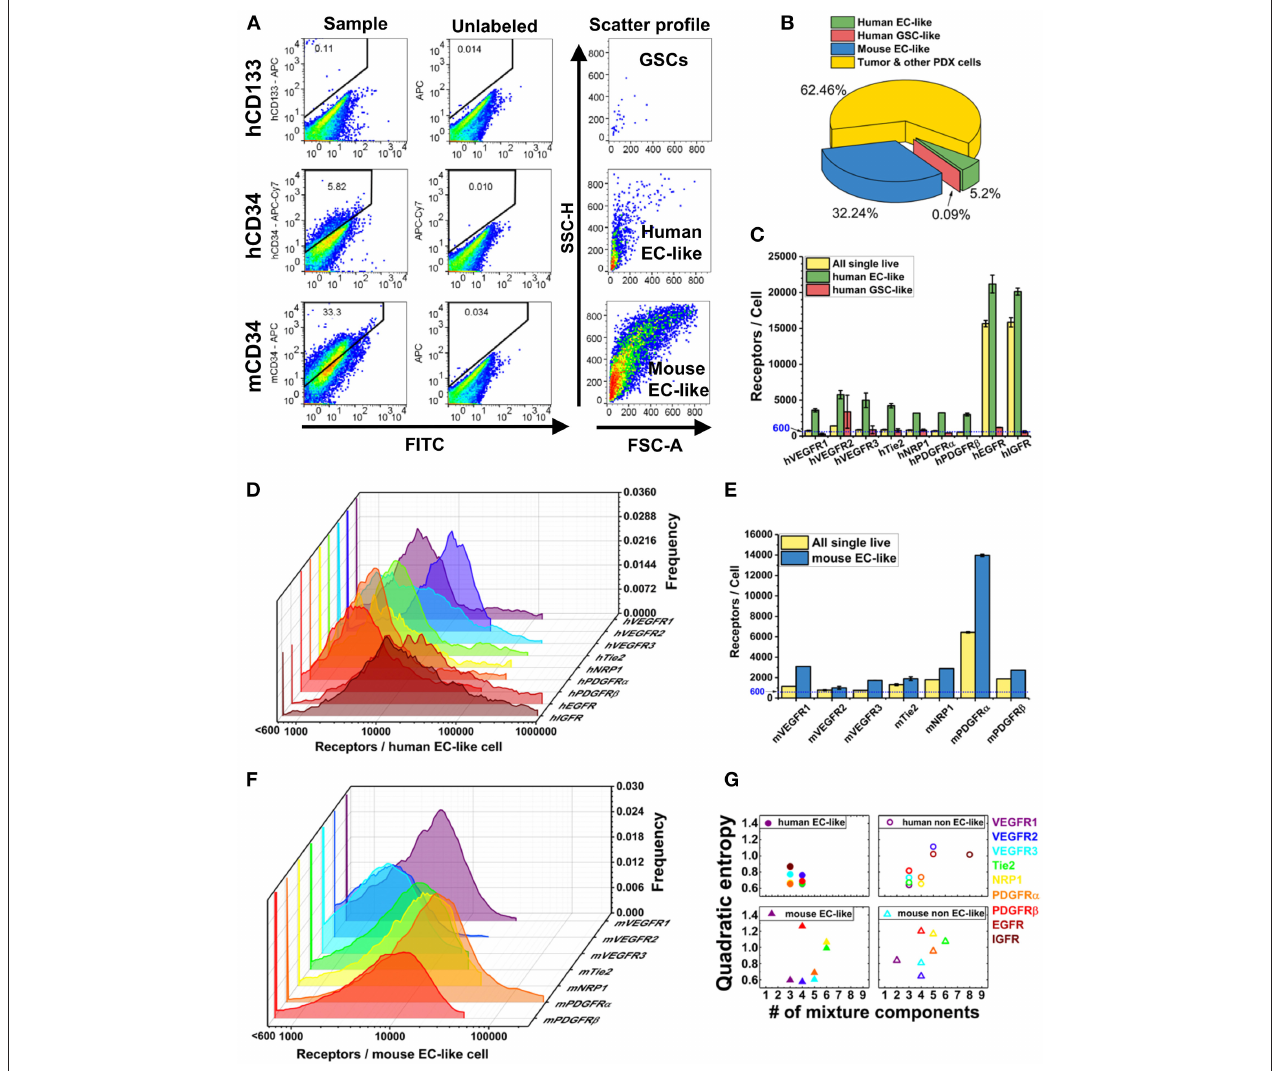
FIGURE 2 | Characterization of plasma membrane RTK concentrations and tumor heterogeneity in GBM39 PDX sample using a LSR Fortessa flow cytometer (BD). We obtain fluorescence signal from 2 to 3 sample tubes for each RTK with 10,000–35,000 live single cells per sample tube. BD FACSDIVA software was used for data acquisition, and FlowJo (TreeStar) software was used for data analysis. (A) Representative flow cytometry plots for gating GSCs (hCD45-hCD133 + ), human EC-like cells (hCD45-hCD34 + ), and mouse EC-like cells (mCD45-mCD34 + ) from live cell population. (B) Percentage of GSCs, human EC-like, mouse EC-like, and tumor & other PDX cells in the GBM39 PDX sample. (C) Ensemble-averaged concentrations and (D) cell-by-cell distributions of plasma membrane VEGFRs, Tie2, NRP1, PDGFRs, EGFR, and IGFR on human EC-like cells. (E) Ensemble-averaged concentrations and (F) cell-by-cell distributions of plasma membrane VEGFRs, Tie2, NRP1, and PDGFRs on mouse EC-like cells. (G) Heterogeneity analysis of RTKs in EC-like and non EC-like cell populations. Number of mixture components estimates how many cell subpopulations there are having different plasma membrane RTK concentrations. Quadratic entropy represents the diversity of RTK concentrations within EC-like and non EC-like